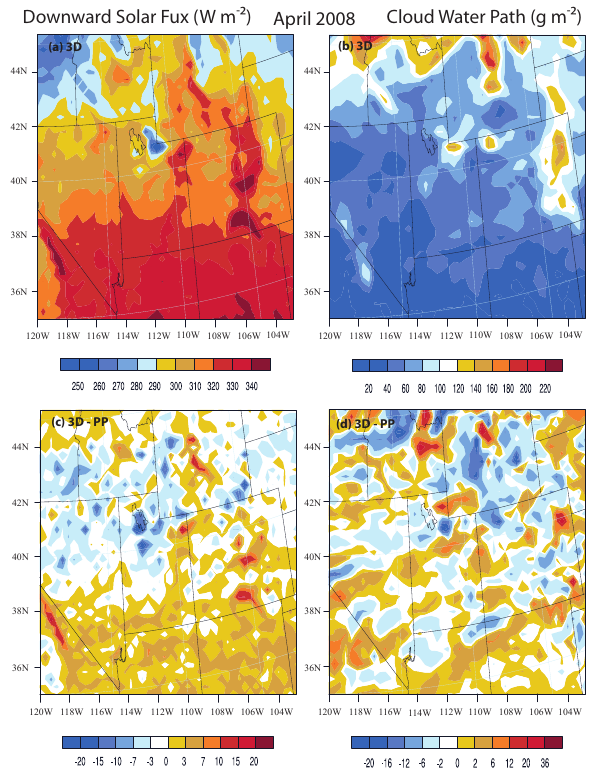
(a) Net Solar Flux (3D - PP, W m-2) (b) Sensible Heat Flux (3D - PP, W m-2)